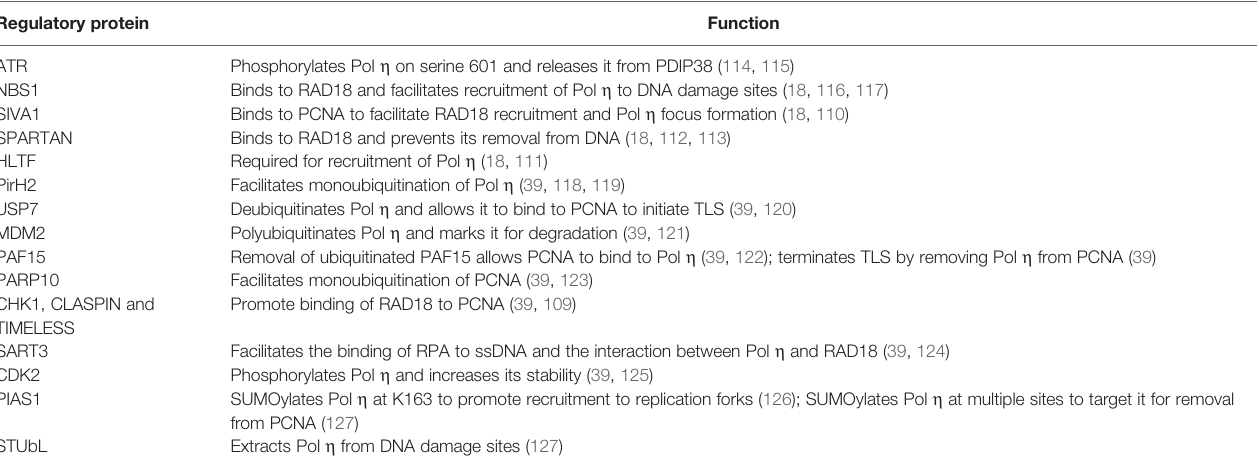
TABLE 2 | Proteins regulating Pol h function in